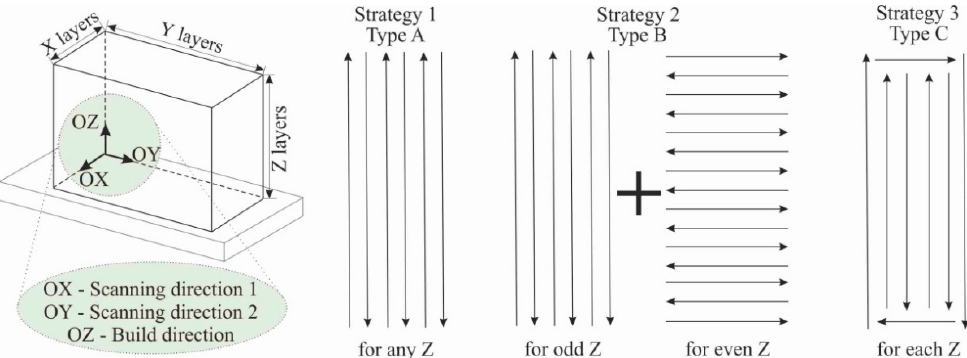
Figure 2. Schematics of scanning strategies for obtaining large-sized copper samples via electron beam wire-feed additive technology.